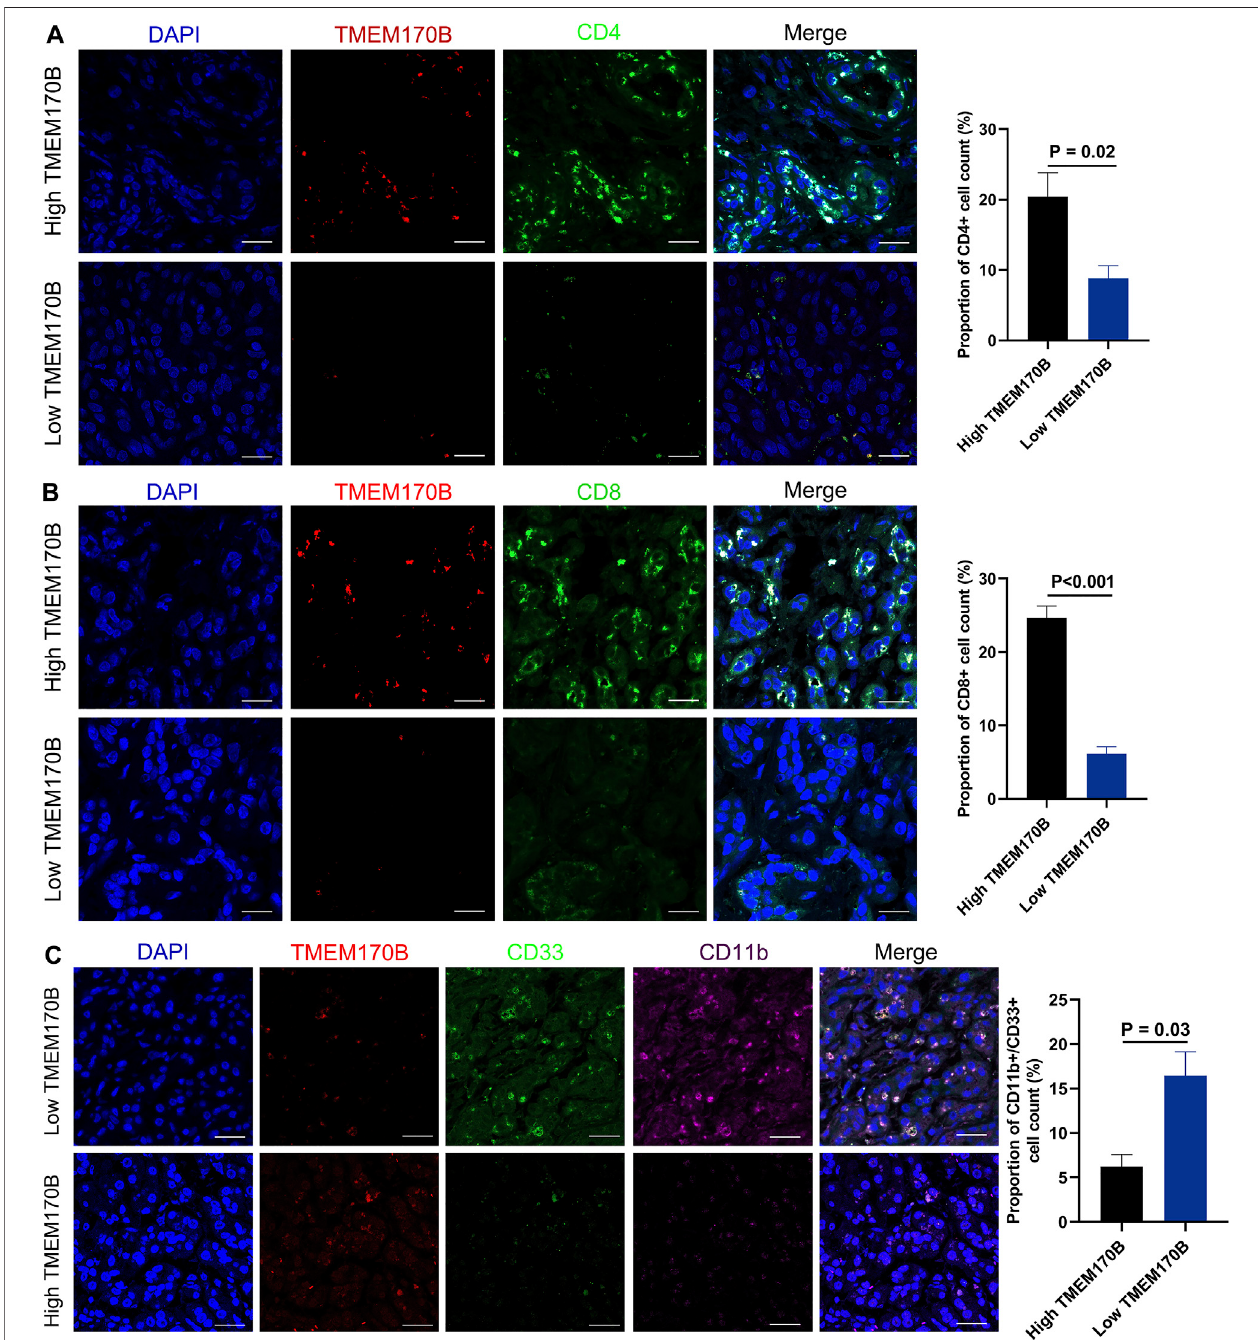
FIGURE 8 | Correlation Between TMEM170B Expression and the In fi ltration Levels of CD4 + T Cells, CD8+T cells, and MDSCs in PAAD tissues. (A) TMEM170B expression was positively correlated with the in fi ltration of CD4 + T cells. (B) TMEM170B expression was positively correlated with the in fi ltration of CD8 + T cells. (C) TMEM170B expression was negatively correlated with the in fi ltration of MDSCs. Scale bar, 30 μ m.